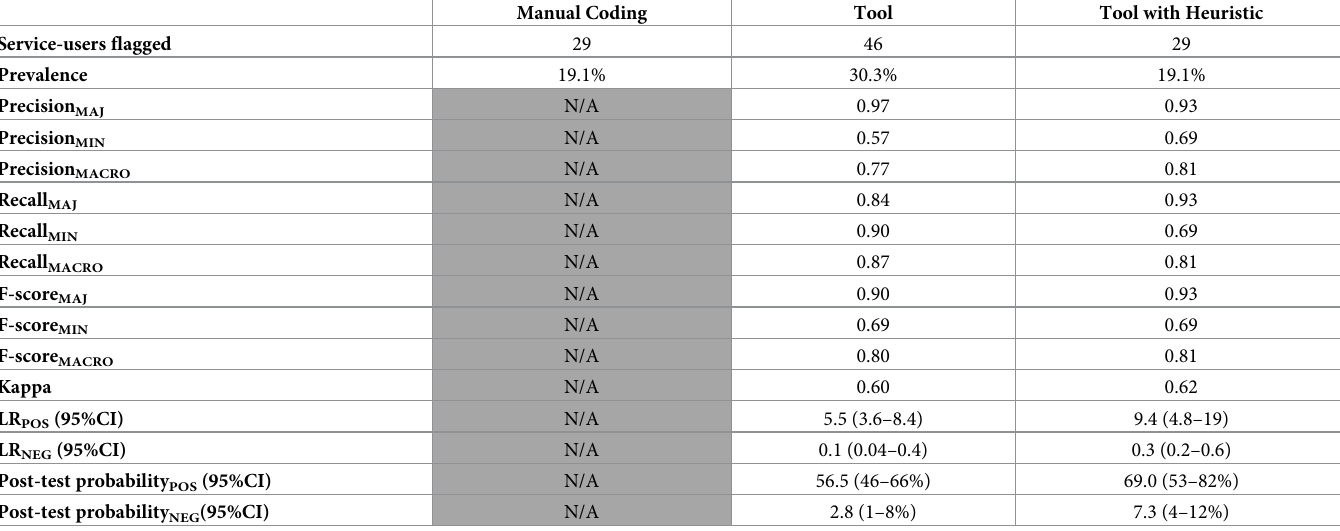
Table 5. Service-user-level evaluation results on the development set (N = 152